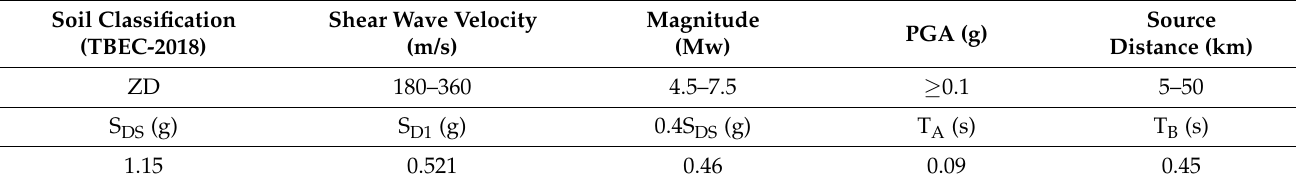
Table 5. The selection criteria of acceleration records and the parameters controlling the shape of the design spectrum. Soil